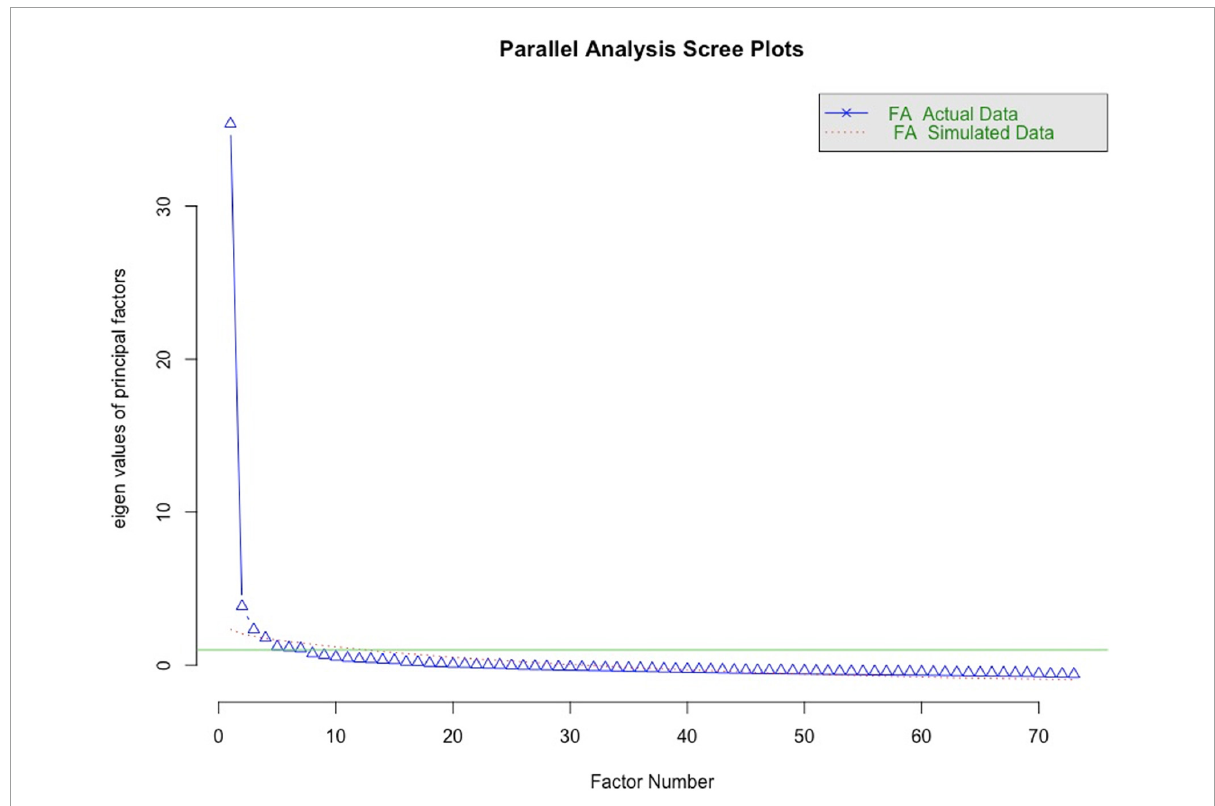
FIGURE1 Scree plot suggesting four factors for the 73-item